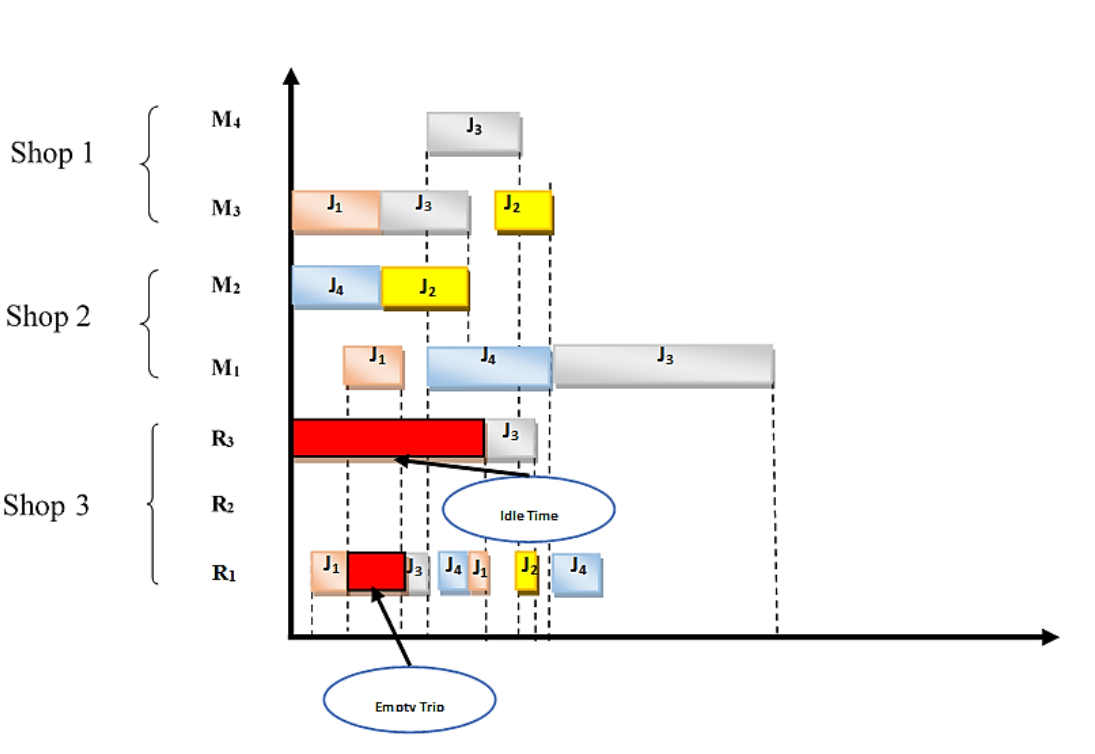
Fig. 3. Example of a solution with empty